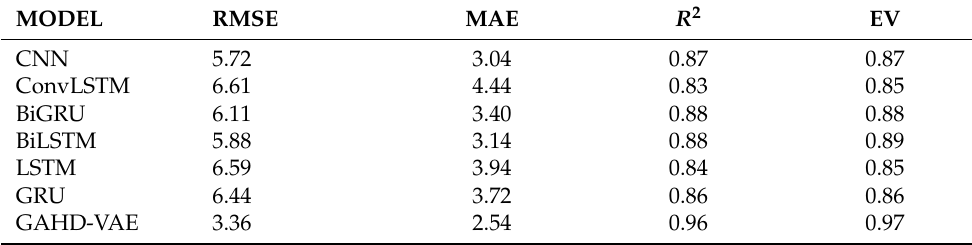
Table 5. Averaged measurements of effectiveness per